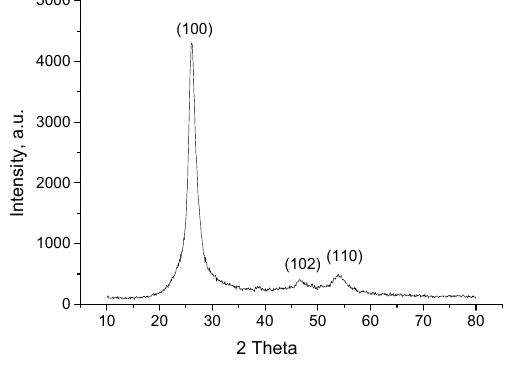
Figure 2. X-ray diffraction (XRD) pattern of nanobranched zinc oxide (ZnO) grown on poly(3,4-ethylenedioxythiphene) doped with a polystyrene sulfonate (PEDOT:PSS)-coated flexible substrate of polyethylene terephthalate (PET).